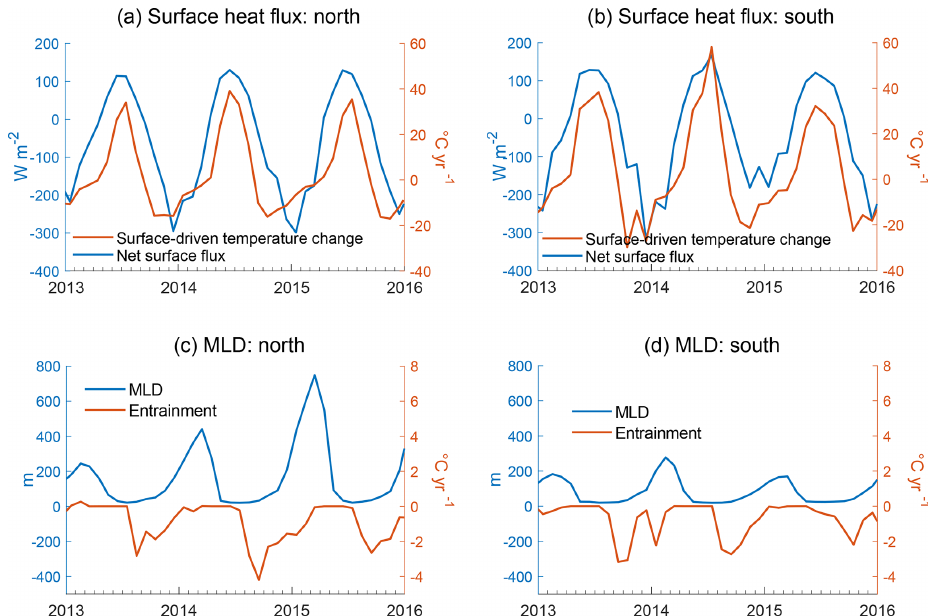
Figure A5. Time series of the individual components that comprise the dominant ECCOv4-r4 temperature budget terms and the associated change in mixed-layer temperature, averaged over the northern (a, c) and southern (b, d) half of the cold blob region. (a) The heat flux into the surface output by the model, defined as Q net in Eq. (1) (Wm − 2 ; blue), and the associated change in mixed-layer temperature, i.e. the surface flux term of the mixed-layer budget ( ◦ Cyr − 1 ; red). (b) MLD (m; blue) and the associated entrainment term of the mixed-layer budget ( ◦ Cyr − 1 ; red).